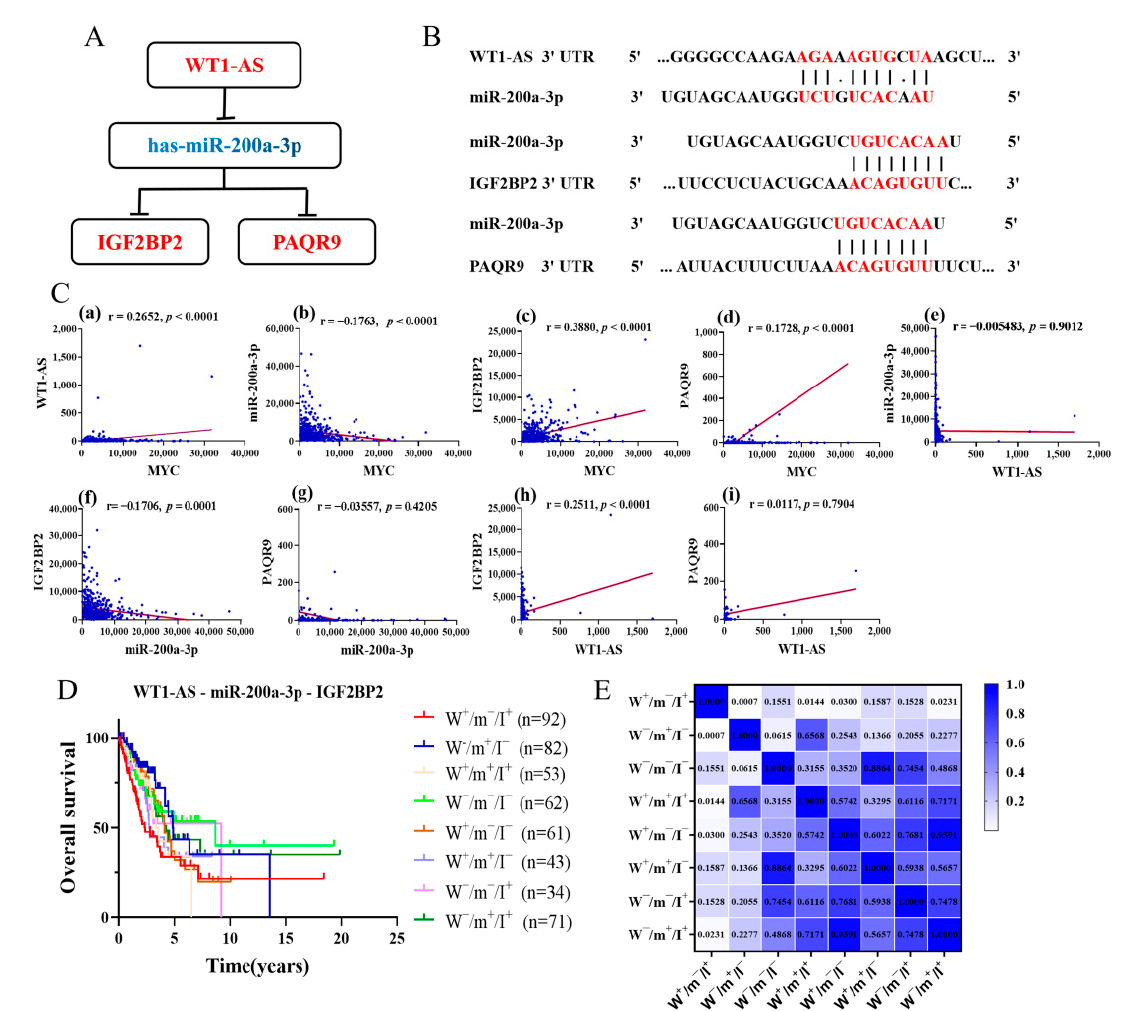
Figure 4. Correlation analysis and validation of WT1-AS, miR200a, and IGF2BP2 expression. ( A ) A schematic model of ceRNA. Blue indicates downregulation and red indicates upregulation. ( B ) Base pairing between miR-200a-3p and the target site in the WT1-AS, IGF2BP2, and PAQR9 predicted by Tarbase and TargetScan, respectively. ( C ) Correlation analysis between WT1-AS, miR200a, IGF2BP2, and PAQR9 in LUAD. ( D , E ) Correlation analysis of different expression patterns of WT1- AS–miR-200a-3p–IGF2BP2 with OS of LUAD patients and with a heat map of the significance of differences.